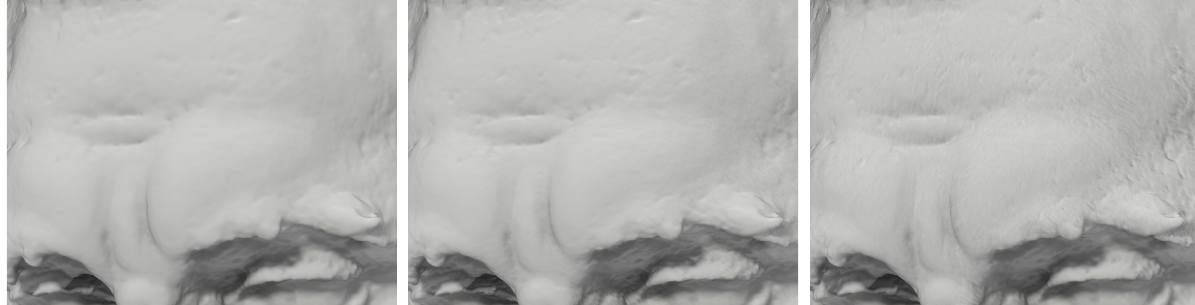
Figure 3. Normal mapping of the Neptune head, colour rendering: a. without normal mapping; b. using 3D modelling and baking from high-poly geometry technique; c. using our solution Sobel-filter